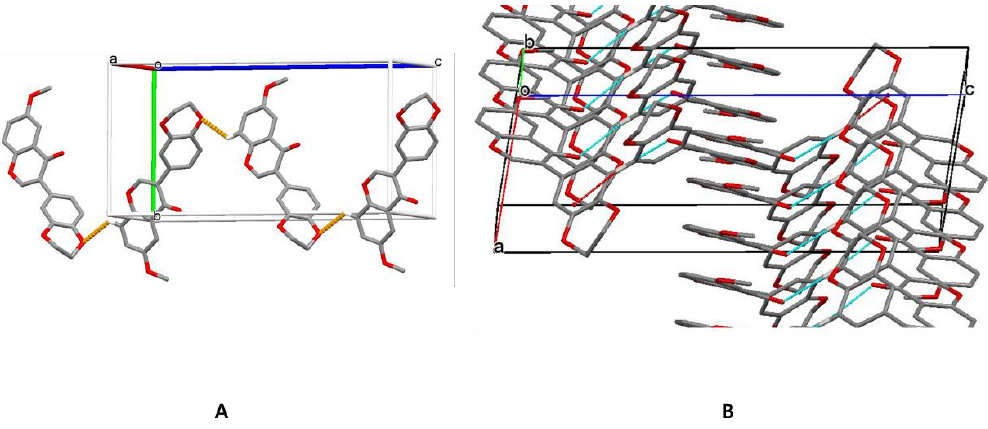
Figure 4. Intermolecular hydrogen bonds lead the molecules along c-axis ( A ) and multiple intermolecular hydrogen bonds stabilize crystal packing by a three-dimensional network ( B ). Table 3. Intermolecular hydrogen bonds for isoflavone 6 [Å and °].